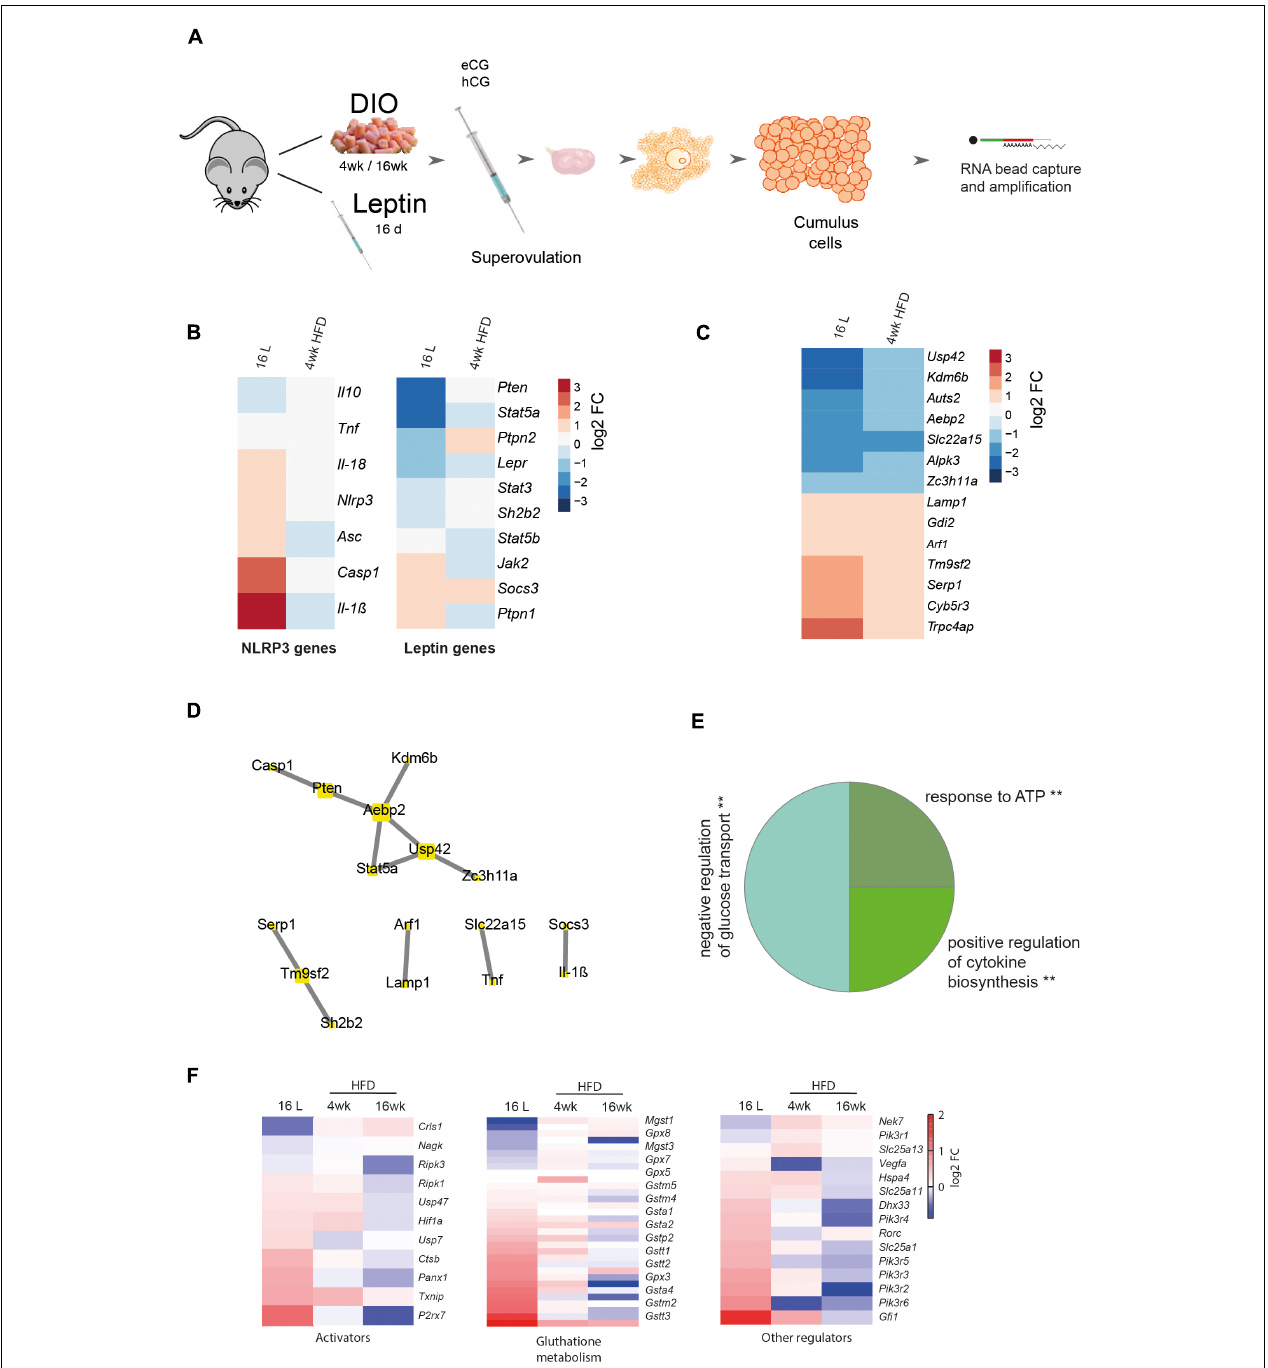
FIGURE 4 | Cumulus cells transcriptome analysis from DIO and pharmacologically hyperleptinemic mice. (A) Experimental design: RNA-Seq analysis of differentially expressed genes in cumulus cells collected from mice: i) with DIO fed chow diet (CD) or high-fat diet (HFD) for 4 or 16 week (ii) with pharmacologically hyperleptinemic (LEPT) injected with saline (C) or 100 µ g of leptin (L) for 16 days (16 L). (B) Heatmap illustrating expression of genes from leptin signaling pathway and NLRP3 inflammasome in 16 L and 4- week HFD normalized by control group fed CD or injected with saline, respectively. Downregulated genes in blue, upregulated genes in orange. The scale on the right matches colors to log 2 fold change (log2 FC) values. (C) Heatmap showing significant changes in major constitutive genes in both conditions 16 L and 4- week HFD. (D) Five main clusters in the network representing strong interaction between selected genes described in (B) and genes presented in (C) . (E) Pie chart that displays the main three gene ontology terms that were significantly enriched in cumulus cells in both conditions 16 L and 4- week HFD. Gene ontology analysis performed with Gene Ontology Enrichment Analysis and Visualization Tool. (F) Heatmaps showing conserved genes involved in NLRP3 inflammasome activation, glutathione metabolism, and other regulations. log2 FC of reads per million (RPM). Created with BioRender.com.